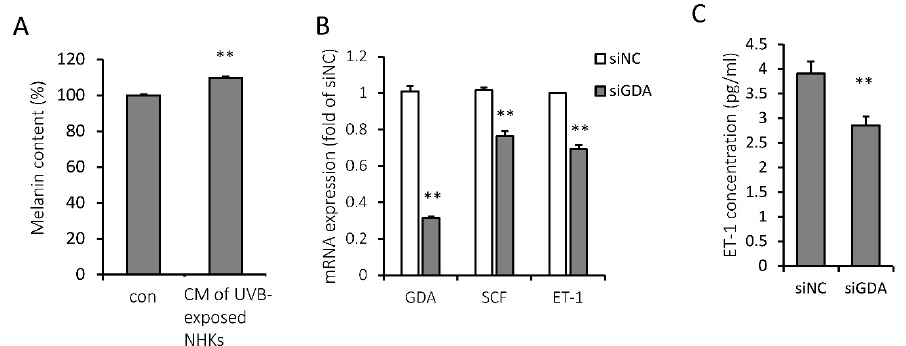
Figure 5. Keratinocyte (KC) guanine deaminase (GDA) expression is involved in the melanogenic property of UV-exposed normal human keratinocyte (NHK)-conditioned media. ( A ) Melanin content was increased when normal human melanocytes (NHMs) were treated with UVB-exposed NHK-conditioned media (CM) for 5 d. ( B ) Stem cell factor (SCF) and endothelin-1 (ET-1) mRNA expression levels in small interfering RNA for guanine deaminase (siGDA)-transfected NHKs were significantly lower than those in negative control siRNA (siNC)-transfected NHKs at 48 h. ( C ) ET-1 concentration was reduced in the conditioned media of siGDA-transfected NHKs at 48 h. ** p <